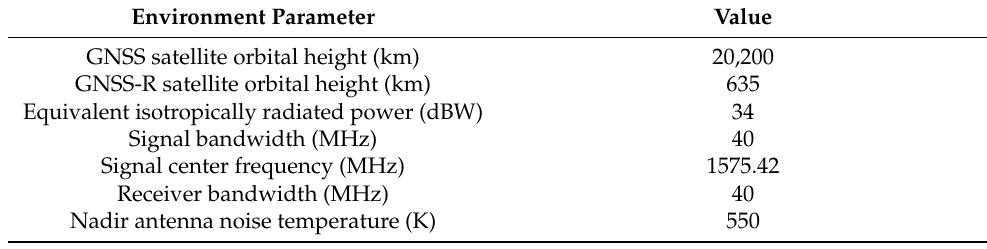
Table 3. Parameters of the simulation environment for SNR calculation.